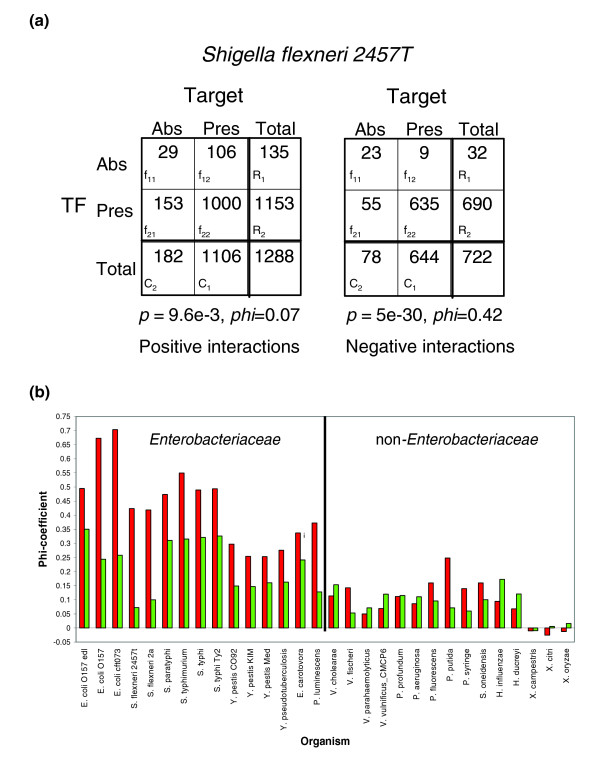
Association between the status of TFs and targets. (a) Contingency tables of the presence or absence of TFs and their targets in S. flexneri 2457T for both positive and negative regulatory interactions. The significance of the associations was calculated using the χ2 test. The association is stronger for negative regulatory interactions than it is for positive regulatory interactions. In a far larger fraction of positive than negative regulatory interactions, the TF is absent while the targets remain in the genome. (b) The strength of association between the presence or absence of TFs and that of their targets, as determined by the phi-coefficient. The association is stronger in bacteria closer to E. coli K12 than in more remote bacteria for both positive and negative regulatory interactions. In closely related bacteria, negative regulatory interactions (phi-coefficients represented by red bars) show stronger association than positive regulatory interactions (phi-coefficients represented by green bars). The values contained in the 60 contingency tables for all organisms in our study and their corresponding p values and phi-coefficients are listed in supplementary Table 2 in Additional data file 1.